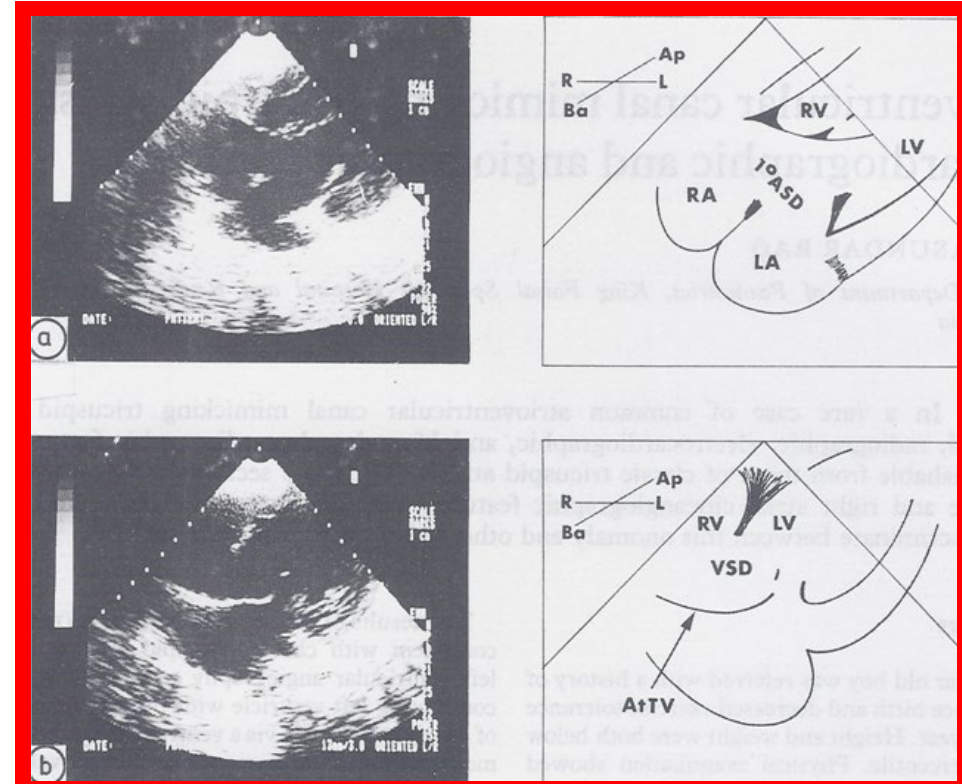
Figure 7. Selected two dimensional, subcostal, four chamber echocardiographic frames with an open ( a ) and closed ( b ) atrioventricular valve. Line drawings on the right of ( a , b ) are made for greater clarity and for labeling. A large ostium primum atrial septal defect (1 0 ASD) is shown in ( a ). When the large atrioventricular valve leaflet is open ( a ), it completely closes the right ventricle (RV) from the right atrium (RA) and the ventricular septal defect (VSD) and allows the emptying of blood from both atria into the left ventricle (LV). When the atrioventricular valve leaflet is closed, ( b ), it continues to occlude the RV from the RA while allowing the VSD to freely communicate between the RV and LV. Ap, Apex; AtTV, atretic tricuspid valve; Ba, base; L, left; LA, left atrium; R, right. Reproduced from Rao PS. Brit Heart J 1987;58:409-412 [30].